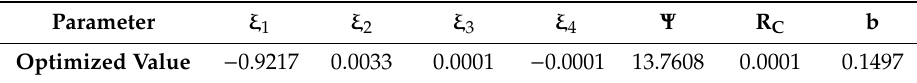
Table 2. Estimated parameters by ASO for SR-12 modular.